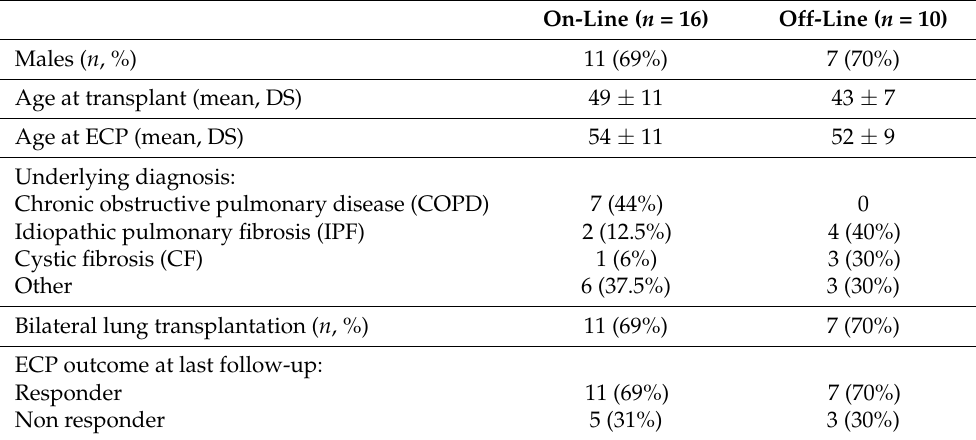
Table 1. Demographic and clinical data of study subjects.